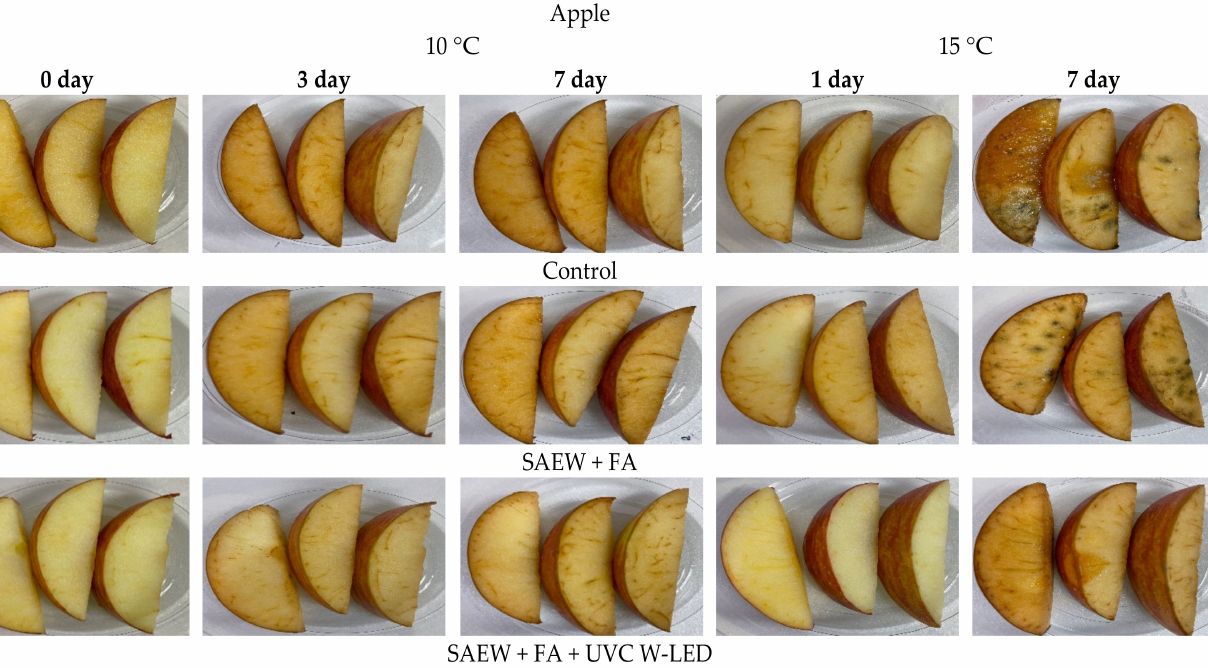
Figure 7. Changes in the overall visual quality of apples with disinfection treatments after storage for 7 days at 10, 15 ◦ C. Control, no extra wash with a sanitizer; SAEW, slightly acidic electrolyzed water; FA, fumaric acid; UVC W-LED, ultravioletC waterproof light-emitting